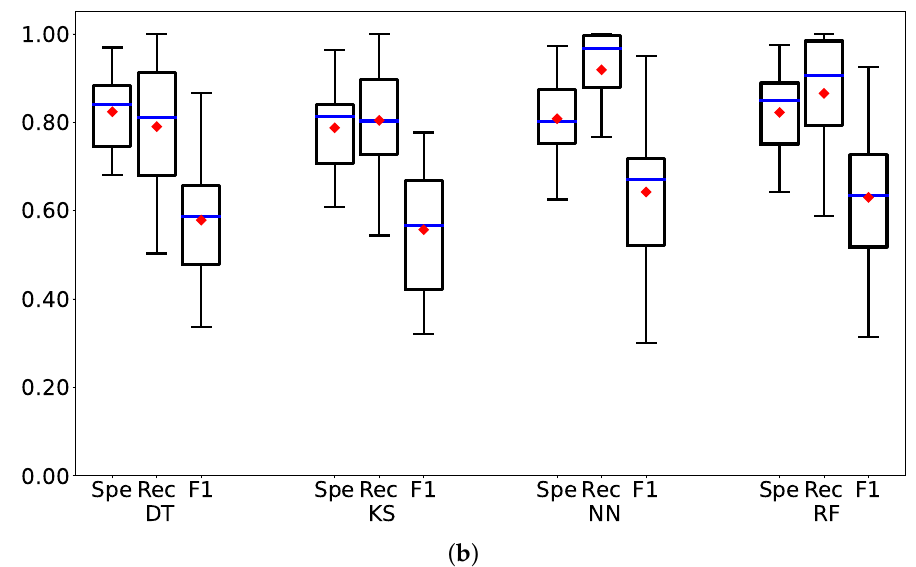
Figure 3. For each classification algorithm (from left to right DT, KS, NN, RF) trained with 12 features (top: ( a )) and 6 features (bottom: ( b )) a triplet of boxplots is shown, reporting the specificity (Spe), recall (Rec), and F1-score (F1) metrics, respectively. ( a ) Boxplot of the metrics using 12 Features. ( b ) Boxplot of the metrics using 6